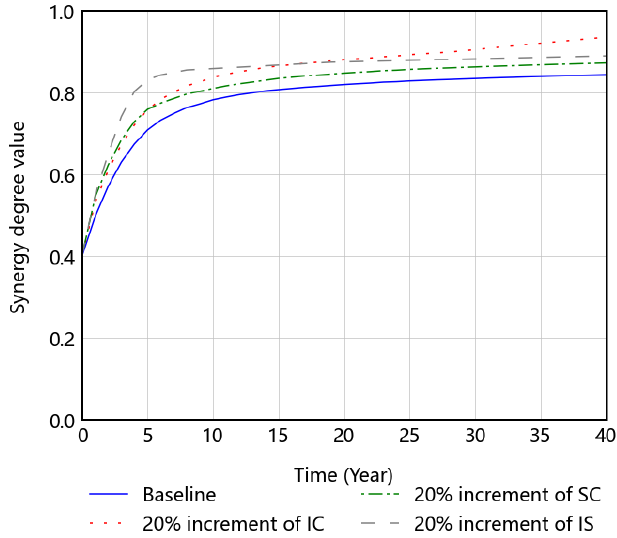
Figure 15. The effects of different strategies on synergy.